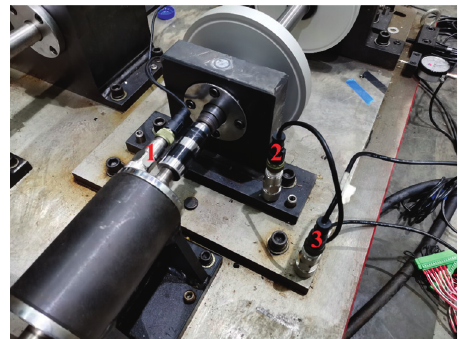
Figure 9: Sensor installation position for the imbalance fault simulation experiment.